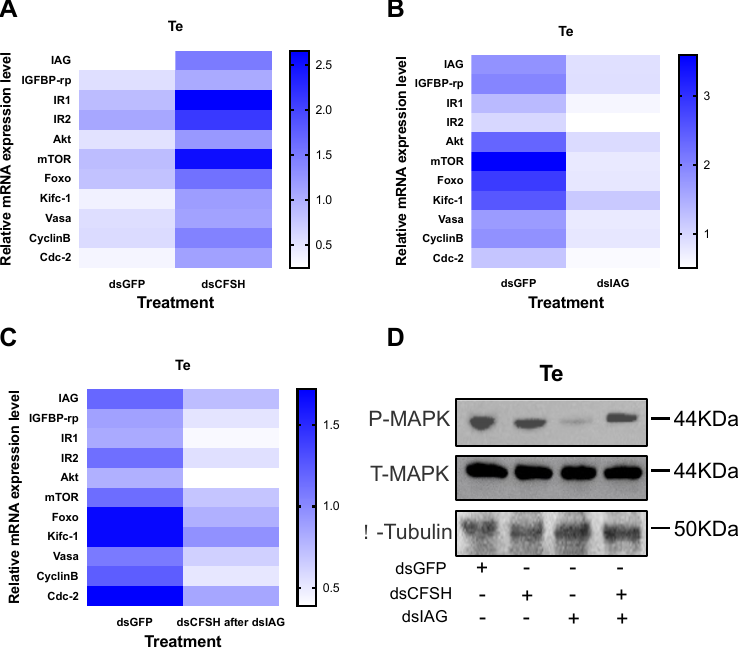
Figure 6. Effects of short-term in vivo injection of dsPtCFSH, dsPtIAG on related genes and proteins expression. ( A ) Heat map expression levels of related genes after injection of dsPtCFSH, dsGFP. Different colors of the same tested gene between the experimental and control groups indicated significant differences. The darker the color in the heat map, the higher the relative expression of the tested genes and vice versa. ( B ) Heat map expression levels of related genes after injection of dsPtIAG, dsGFP. Different colors of the same tested gene between the experimental and control groups indicated significant differences. The darker the color in the heat map, the higher the relative expression of the tested genes and vice versa. ( C ) Heat map expression levels of related genes after injection of dsPtIAG followed by dsPtCFSH, dsGFP. Different colors of the same tested gene be- tween the experimental and control groups indicated significant differences. The darker the color in the heat map, the higher the relative expression of the tested genes and vice versa. ( D ) Changes in phosphorylated-MAPK expression levels after injection of dsPtIAG followed by dsPtCFSH, dsPtCFSH, and dsGFP. Total-MAPK, β -tubulin as internal reference proteins. The scale bar is shown in the lower right corner. Vertical bars represent means ± SEM (n = 5). Significant differences among stages are indicated by different letter labels (one-way ANOVA followed by post hoc Tukey’s mul- tiple group comparison p < 0.05).